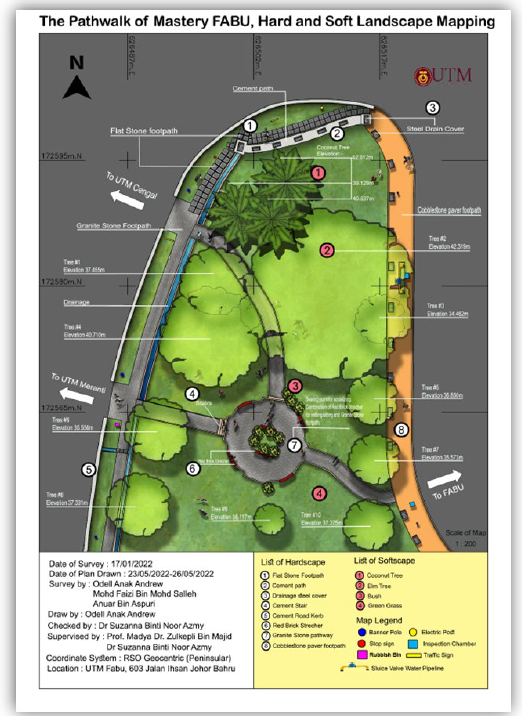
Figure 3.5 The Pathwalk of Mastery FABU, Hard and Soft Landscape Mapping produced via adaption of